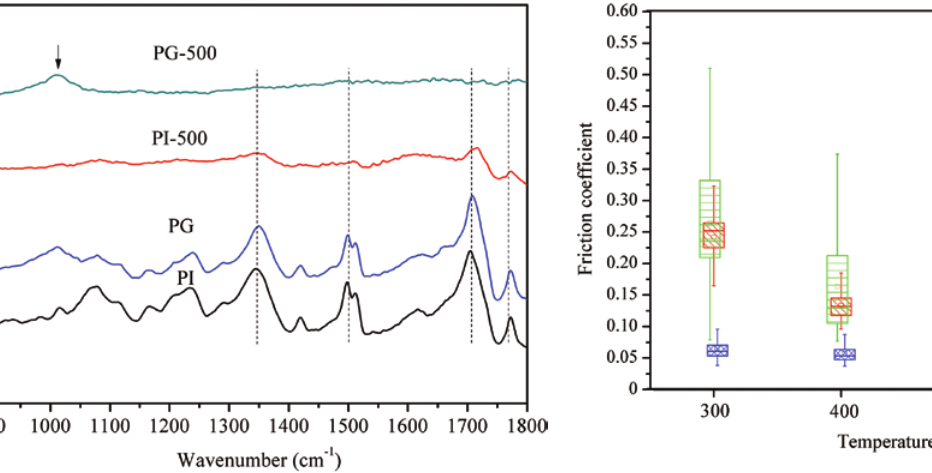
Figure 6: Friction coefficients of GR, PI, and PG composite at various temperatures under the applied load of 300